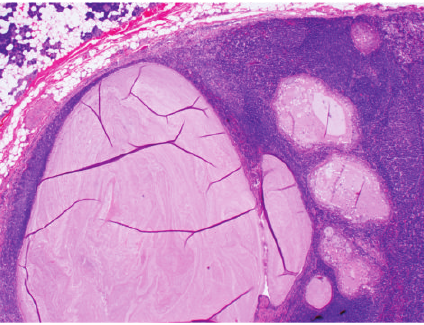
Figure 2: Low magnification of the intraparotid lymph node harboring a cystic neoplasm (20x; H&E).